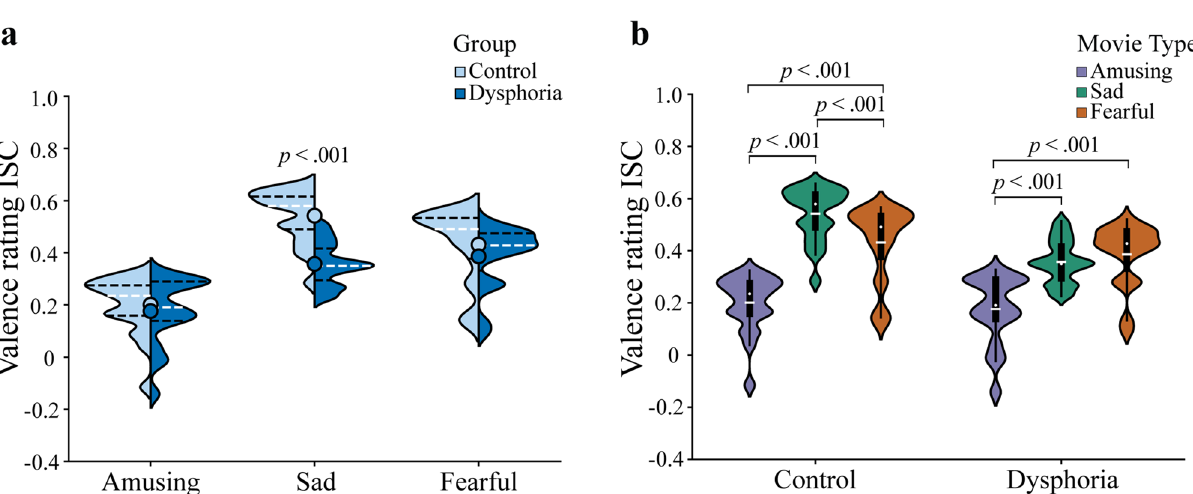
Figure 4. Violin plots for the valence rating ISC for each movie type and research group. For both ( a , b) , violin plot outlines illustrate the distribution of ISC estimates using kernel probability density with the bandwidth of 0.2. Wider area of the violin plot represents a higher probability of the ISC, and the thinner area corresponds to a lower probability. ( a ) Group differences in each movie type are illustrated. Each side of the violin corresponds to a different group. Dots denote means of the ISC. Horizontal white dotted lines show median of the ISC and horizontal black dot lines represent the interquartile range of the ISC. ( b ) Differences of movie type within control and dysphoric group are shown. White dots on the violin plots show the median of the ISC and horizontal white lines represent the means of the ISC. The black bars in the centre of violins denote the interquartile range (IQR) of the ISC. The black lines stretched from the bars show the lower and upper adjacent values (1.5 times the IQR) of the ISC,